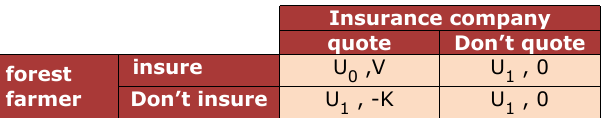
Table 2. Game between the insurance company and the forest